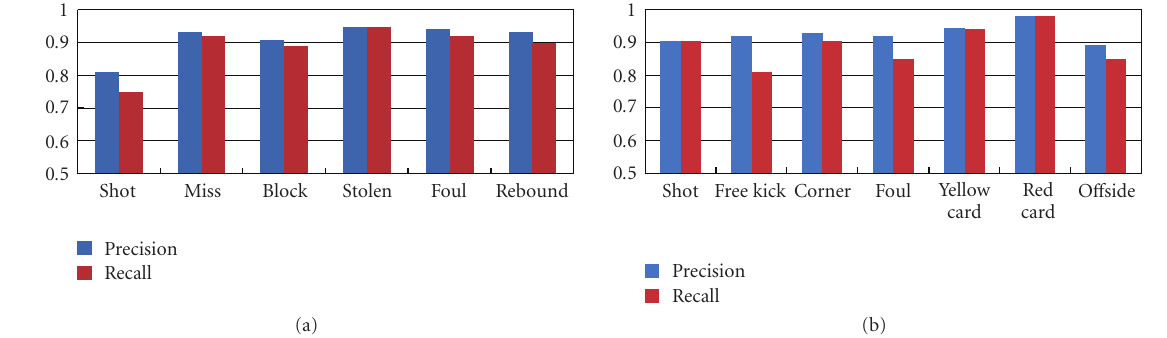
Figure 10: Refined event detection result on (a) basketball and (b) football matches.